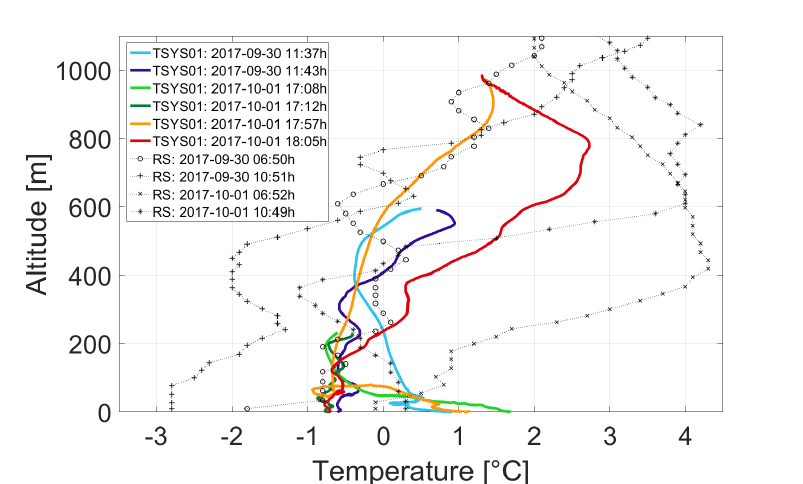
Figure 19. Profiles obtained from three flights with quadrocopter ALICE on 30 September and 1 October 2017 and four radio sondes. The times are provided in UTC. The ascents are provided in brighter colors (cyan, bright green, orange), and the descents in darker colors (blue, dark green,